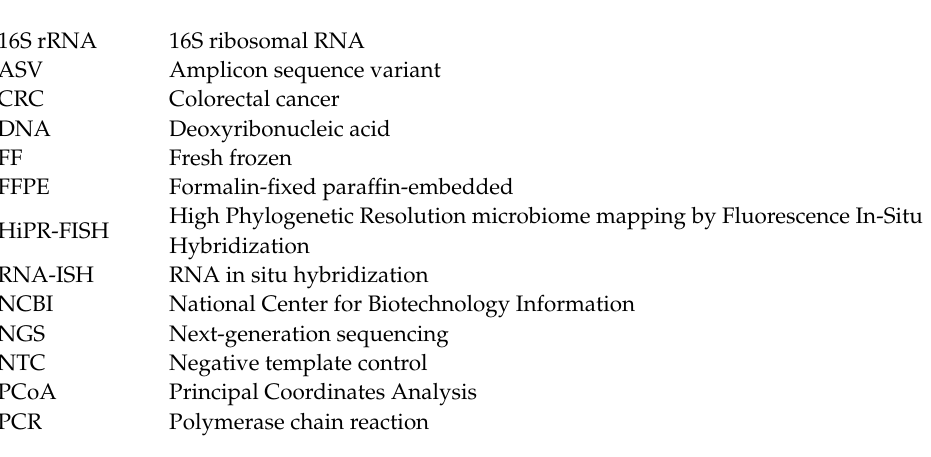
and FFPE sample pairs. Figure S7. Fusobacterium putative species identified in FF and FFPE samples. Figure S8. Fusobacterium, Bacteroides and Propionibacterium in normal and colorectal cancer FFPE tissues. Figure S9. Correlation between microbiome concordance and tumor content in FF and FFPE sample pairs. Figure S10. Comparison of bacterial composition across studies. Figure S11. Microbiota-associated profiles in FFPE tissue samples with “high” and “low” comparability. Table S1. Pathologic data of the samples’ patients of the study. Table S2. Summary of the bacterial detection by RNA-ISH in FFPE samples and 16S on FF and FFPE